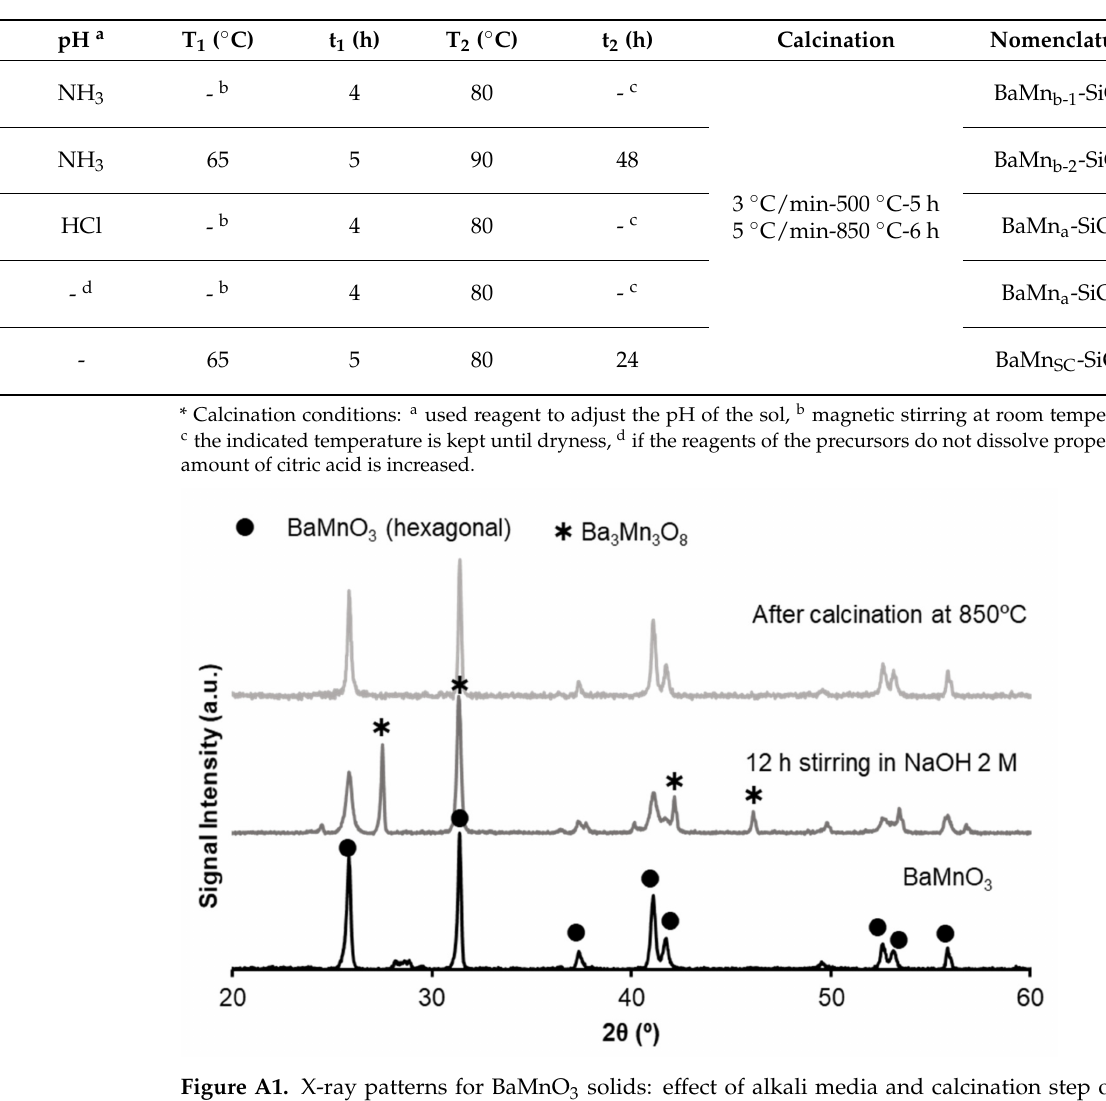
Table A1. Synthesis conditions and nomenclature.